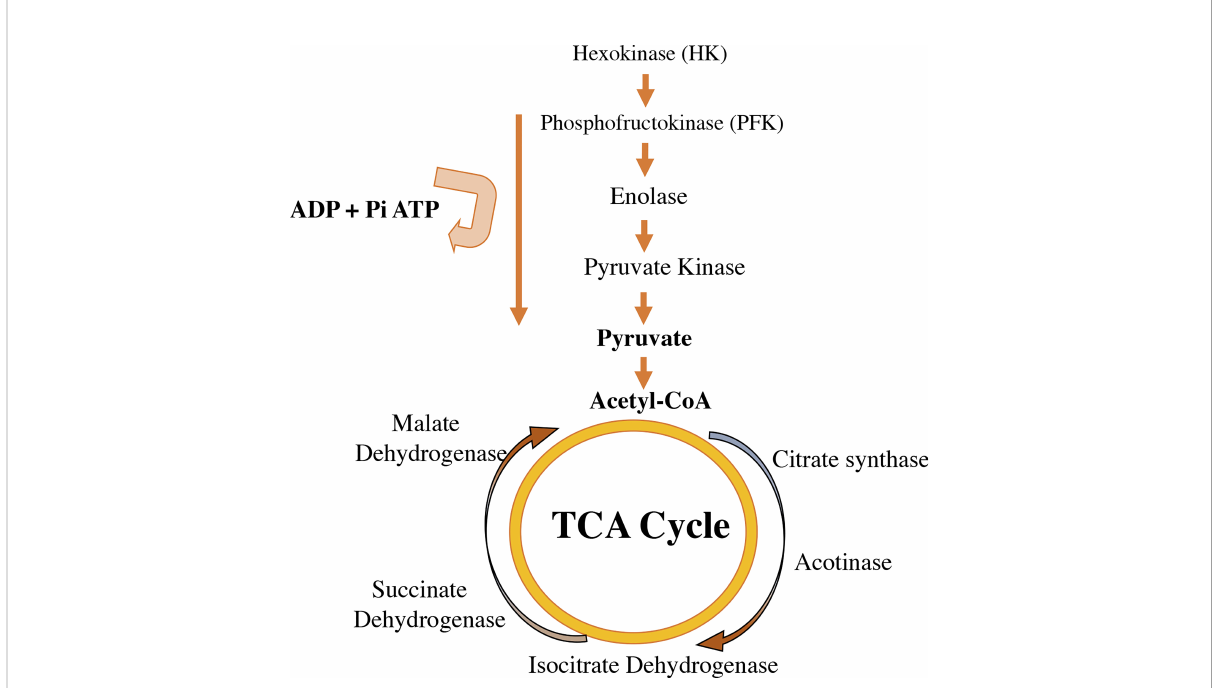
FIGURE 5 Proteins secreted by white adipocytes (adipokines) and brown adipocytes ( “ batokines ” ). The recognition of adipose cells as an endocrine organ is relatively recent. Many of the cardiovascular complications observed in obesity are a consequence of the altered secretion of these proteins in hypertrophied white adipose cells. Brown adipocytes secrete proteins that regulate some of the most important tissues involved in the control of body weight, lipid and carbohydrate metabolism. BMP8b, bone morphogenetic protein 8b; IGF-1, insulin-like growth factor 1; IGFBP2, insulin-like growth factor binding protein 2; IL6, interleukin 6; NRG-4, neuregulin 4; SLIT2-C, cleft 2 homologous protein; NRG4, neuregulin 4; ANGPLT2, angiopoietin-like peptide 2; IL1, interleukin 1; FGF21, fi broblast growth factor 21; TNF a , tumor necrosis factor alpha; 12-HEPE, 12- hydroxyeicosapentaenoic acid; AII, angiotensin